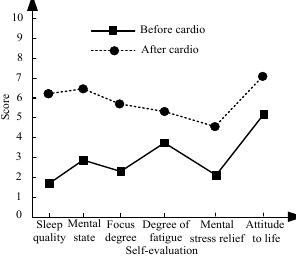
Figure 4. Self-evaluation index evaluation